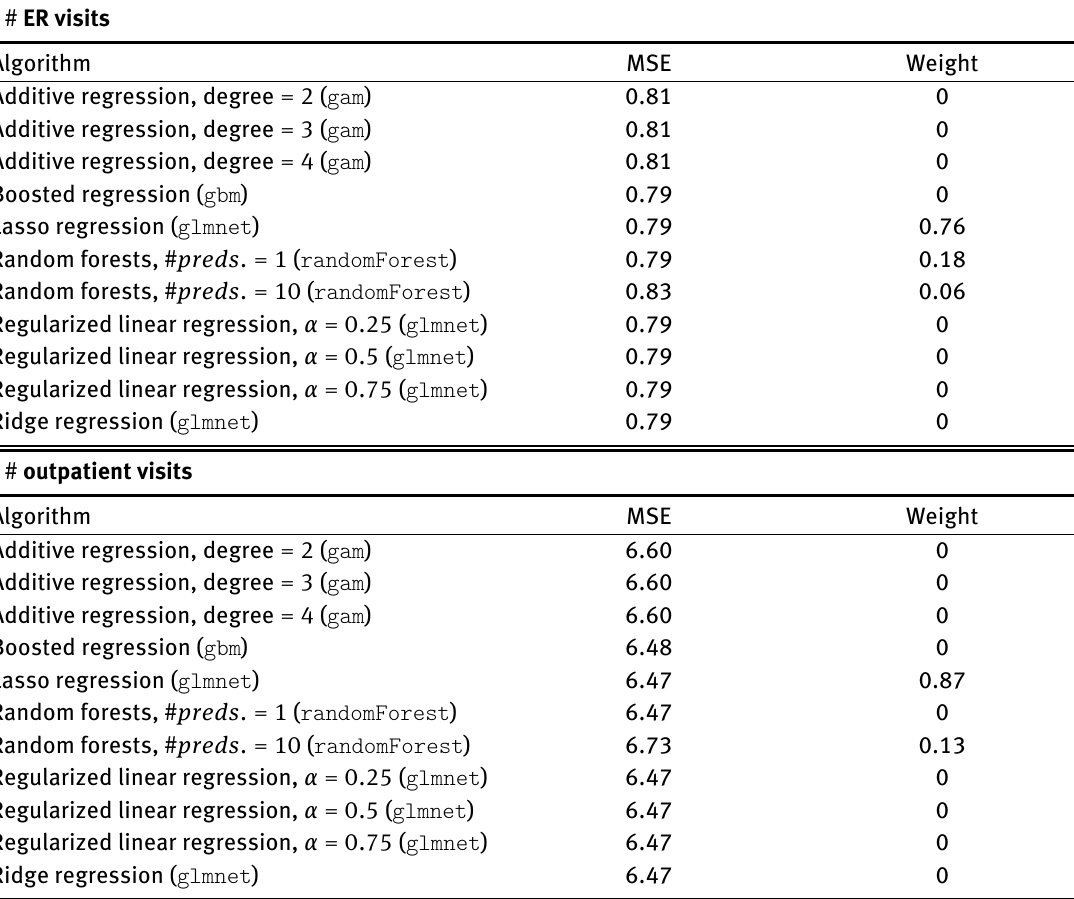
Table B5: Error and weights for candidate algorithms in response ensemble for RCT